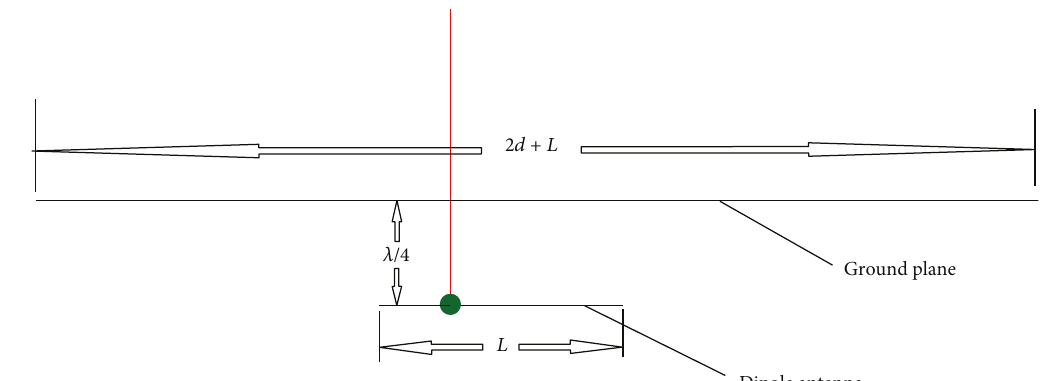
Figure 5: Ground plane o ff set de fi ned for the wing span study.